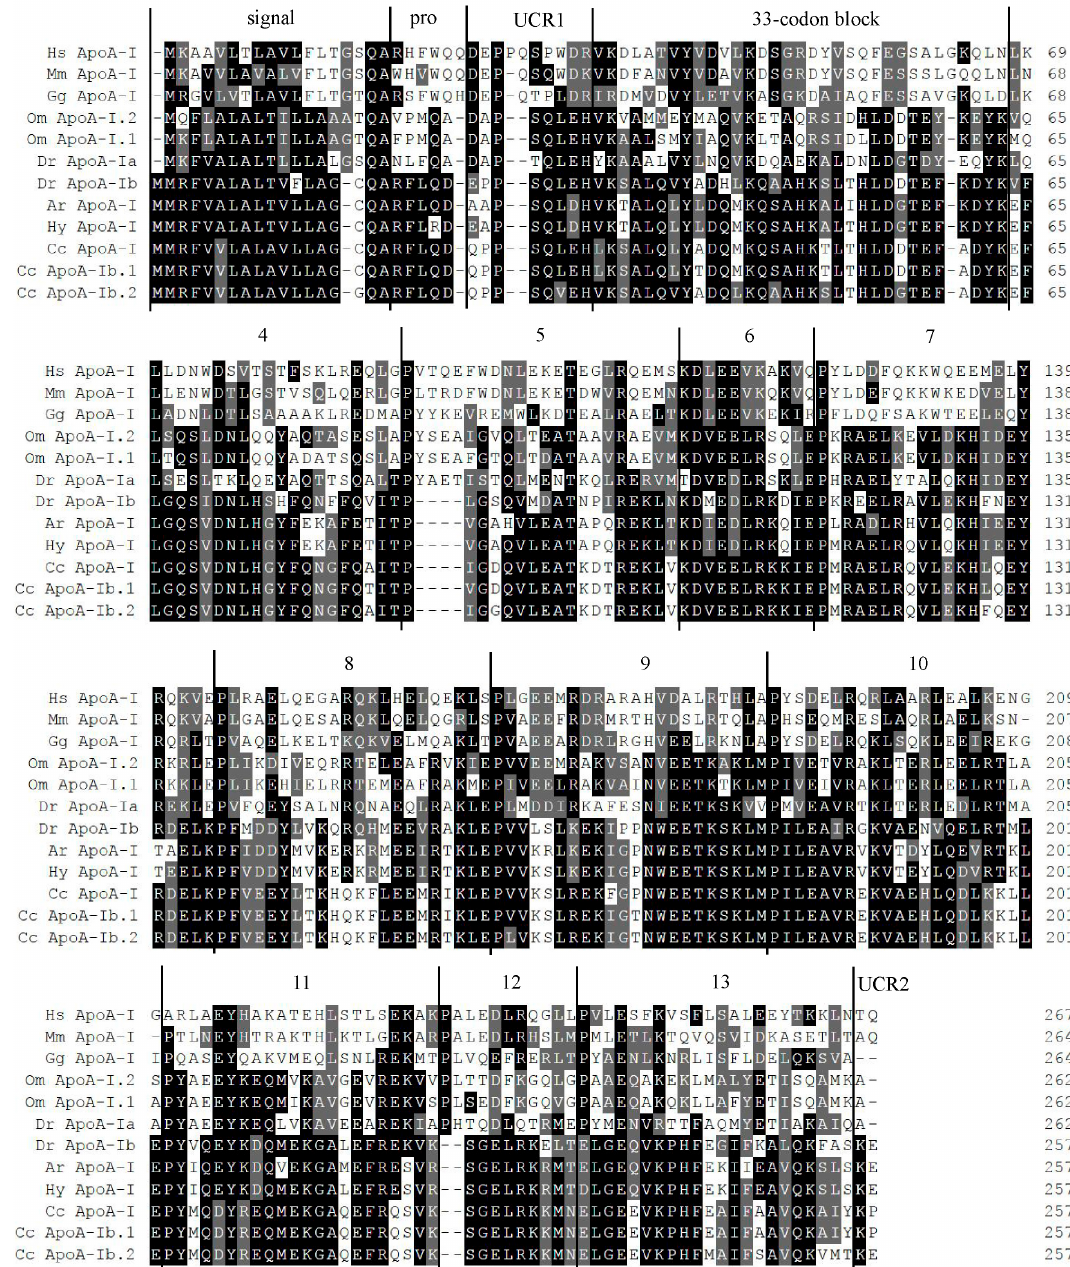
Figure 1. Comparison of deduced amino acid sequences of C. carpio ApoA-Ibs with several other species of vertebrates. Their accession numbers are as follows: Cc-ApoA-Ib.1 ( Cyprinus carpio , KJ741859), Cc ApoA-Ib.2 ( Cyprinus carpio , KJ741860), Cc ApoA-I ( Cyprinus carpio , KF268349), Ar ApoA-I ( Hypophthalmichthys nobilis , unpublished result), Hy ApoA-I ( Hypophthalmichthys molitrix , ADF97611), Dr ApoA-Ib ( Danio rerio , NP_001093614), Dr ApoA-Ia ( Danio rerio , NP_571203), Om ApoA-I.1 ( Oncorhynchus mykiss , NP_001117719), Om ApoA-I.2 ( Oncorhynchus mykiss , NP_001117720), Gg ApoA-I ( Gallus gallus , NP_990856), Mm ApoA-I ( Mus Musculus , NP_033822), Hs ApoA-I ( Homo sapiens , NP_000030). Boundaries of the signal peptide (signal), the propeptide (pro), the unrelated coding regions 1 and 2 (UCR1 and UCR2, respectively), the 33-codon block and the 11- or 22-residue repeats (4 to 13) are indicated above the sequence of Hs ApoA-I. Identity is covered with black and grey color.